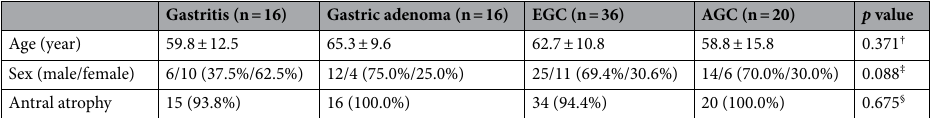
Table 1. Baseline characteristics of enrolled subjects (n = 88). Values are expressed as mean ± standard deviation or number (percentage), unless otherwise specified. Differences between the groups were compared with † one-way analysis of variances, ‡ chi-square test, or § Fisher’s exact test. EGC Early gastric cancer, AGC Advanced gastric